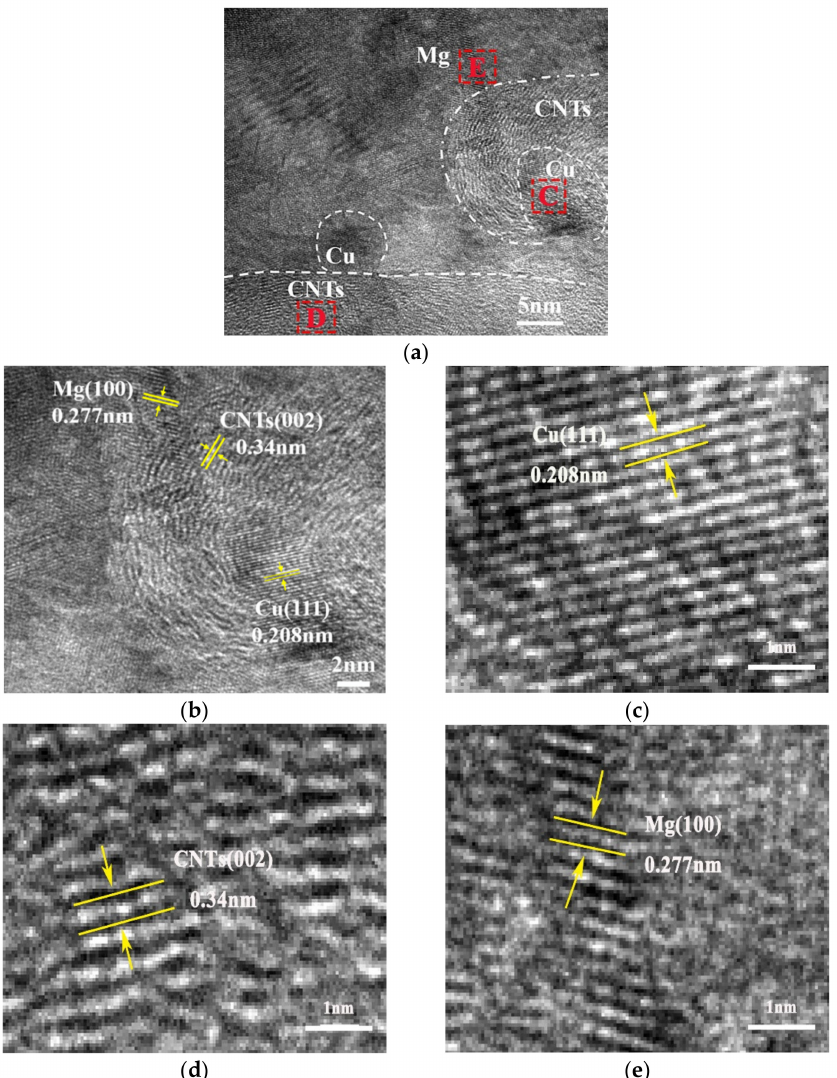
Figure 5. HRTEM diagrams of CNTs/refined-AZ61 composites with ( a ) low magnification and ( b – e ) high magnification from ( a